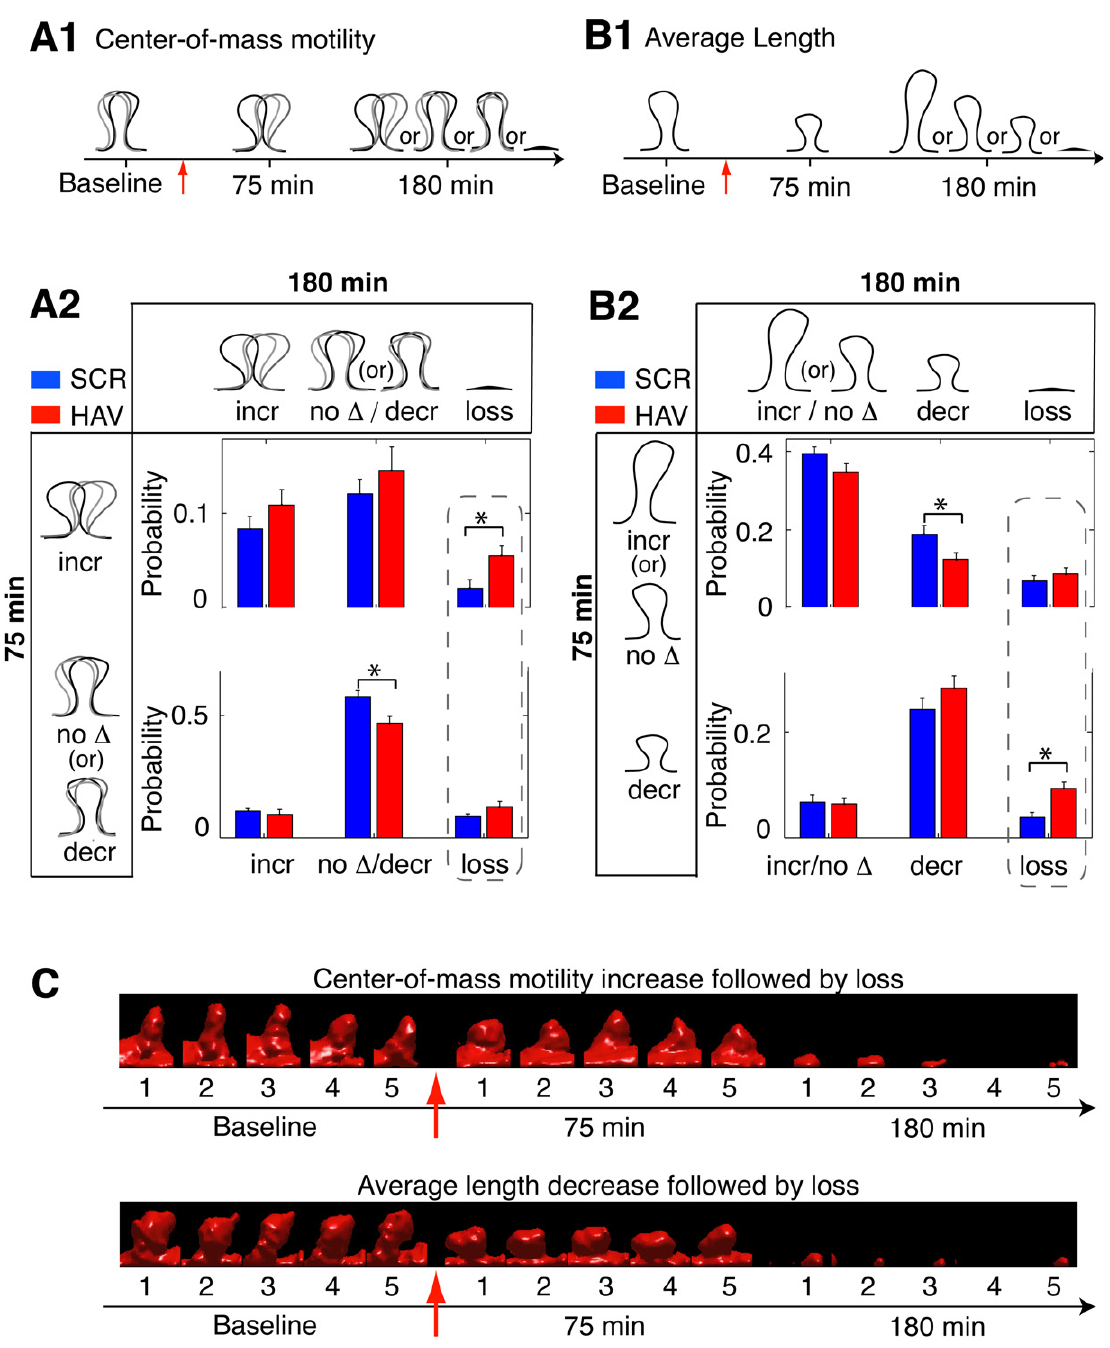
Figure 7. N-cadherin disruption results in increased correlation between early changes in spine dynamics and later spine loss. (A1) Schematic show- ing a spine with an increase in center-of-mass motility at 75 minutes and its possible states (with respect to center-of-mass motility) at 180 minutes. (A2) Joint probability distribution between center-of-mass motility at 75 minutes and spine fate (with respect to center-of-mass motility) at 180 minutes (incr – probability of increase, no Δ – no change, decr – decrease. The possible states of a spine at 75 and 180 minutes yield a joint distribution with 2 × 3 states in total. This distribution for HAV-treated spines is signifi cantly different from that of SCR-treated spines (control) as indicated by ‘*’ (see Materials and methods section). The dashed box highlights the comparisons of interest and points to the increase with respect to control in the fraction of spines that fi rst show an increase in center- of-mass motility and are then lost. Note that the fraction of spines that show other center-of-mass motility (no change or decrease) at 75 minutes and are then lost is not different between treatment and control. At 75 minutes, the no change and decrease in motility states have been merged to improve visualization while highlighting the signifi cant effect in increase in motility. (B1) Schematic showing a spine with decrease in average length at 75 minutes and its possible states (with respect to average length) at 180 minutes. (B2) Joint probability distribution between average spine length behavior at 75 minutes and spine fate 180 min- utes; 2 × 3 states in total. The joint distributions of HAV- and SCR-treated spines are signifi cantly different. Further, spines that show a decrease in length at 75 minutes are preferentially lost at 180 minutes after HAV treatment - dashed box. We tested for correlations between average length and center-of-mass motility at 75 minutes and found no signifi cant difference between HAV and control spines (data not shown). At 75 minutes, the no change and increase in length states have been merged to improve visualization while highlighting the signifi cant effect in decrease in length. (C) (Top panel) Time-lapse, volume rendered images of an HAV-treated spine that showed an increase in motility at 75 minutes and was subsequently lost at 180 minutes. (Bottom panel) Volume rendered images of an HAV treated spine that fi rst decreased in length and was then lost. Red arrows indicate the 10-minute application of treatment at time t = 0